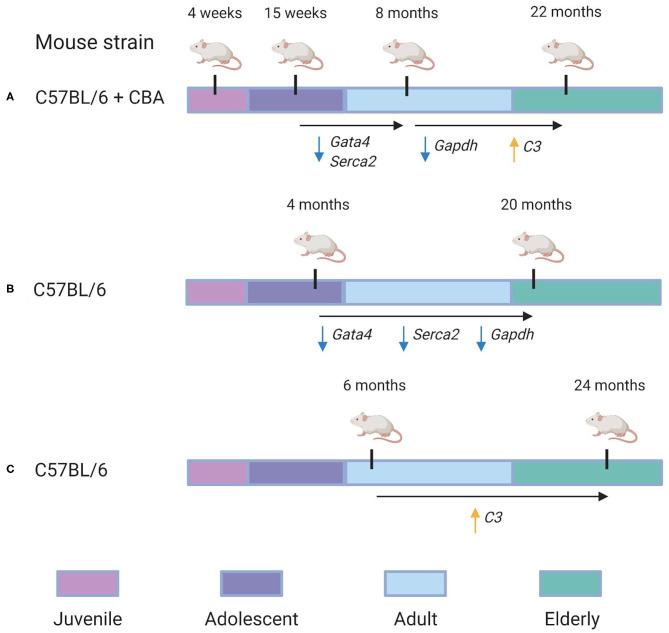
Re-evaluation of time-dependent transcriptional changes of selected transcripts. Specific genes in which conserved patterns were identified between our analysis and others are also annotated. (A) The experimental design used in our analysis. C57BL/6 + CBA hybrid mice of four different age groups—4 weeks, 15 weeks, 8 months, and 22 months—were analyzed to identify gene expression changes associated with aging. We identified that Gata4 and Serca2 were downregulated between the 15 week and 8 month groups (with LFC = −1.5 and LFC = −1.8, respectively). Furthermore, Gapdh was downregulated in the 22 month group compared to the 8 month group (LFC = −3.9), while C3 was identified as upregulated in the 22 month group compared to the 8 month group (LFC = 5.1). (B) Overview of the experimental design used in a 2002 study by Bodyak et al. (2002). Their group compared C57BL/6 mice of 4 months age with those of 20 months age. It was identified that Gata4, Serca2, and Gapdh were all downregulated in the 20 month group compared to the 4 month group. (C) Overview of the experimental design used in a 2019 study by Bartling et al. (2019). They compared C57BL/6 mice of 6 months age with those of 24 months age. They identified that C3's expression was significantly upregulated in the 24 month group compared to the 6 month group.